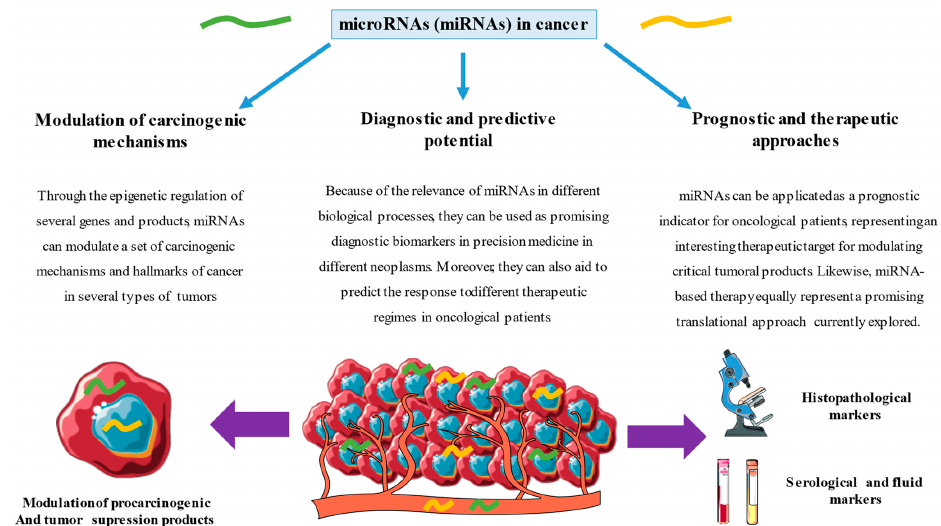
Figure 3. Roles and applications of microRNAs in cancer. Summary of possible applications of mi- croRNAs in explaining the pathophysiology of carcinogenesis and demonstrating usefulness in the diagnosis and prognostic assessment of di ff erent neoplastic diseases.